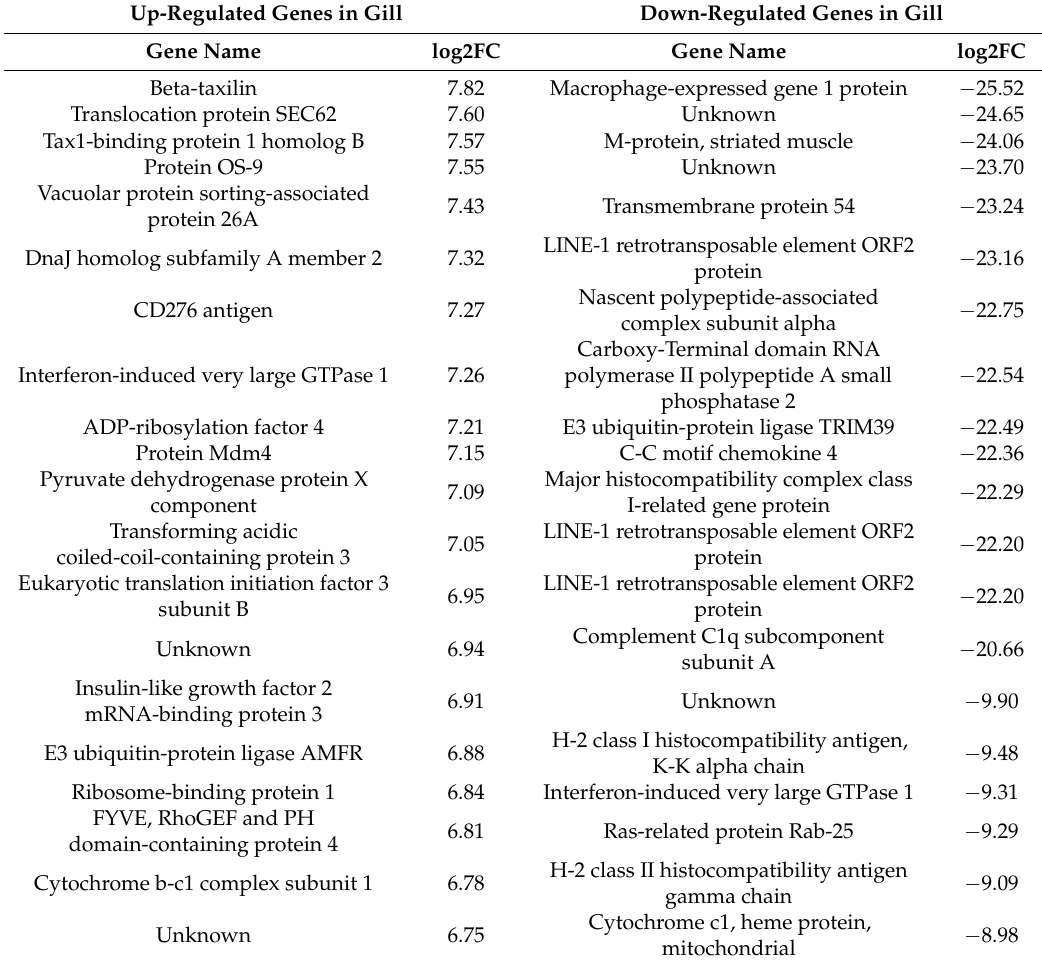
Table 2. Top 20 up- and down-regulated DEGs gill